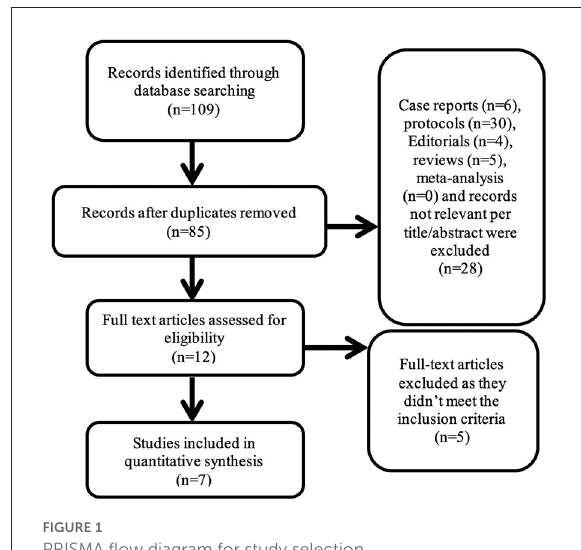
FIGURE1 PRISMA flow diagram for study